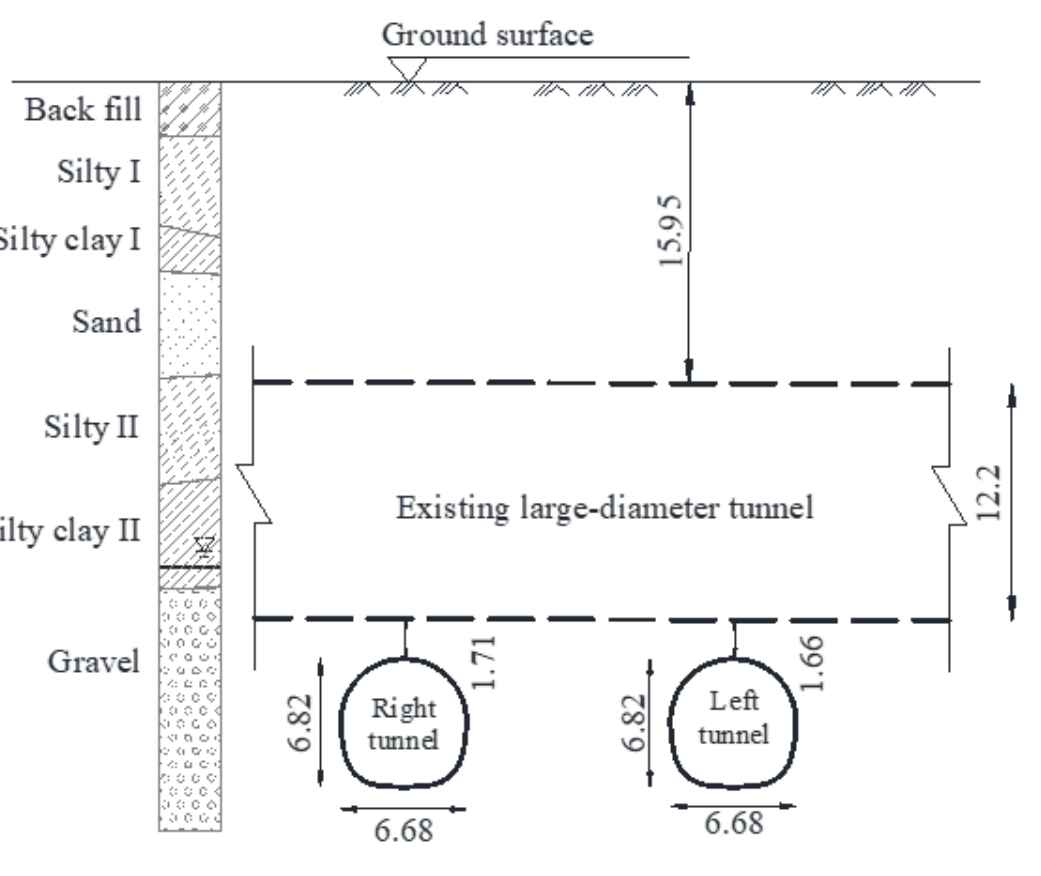
Figure 4. Typical intersection zone soil profile (unit: m).